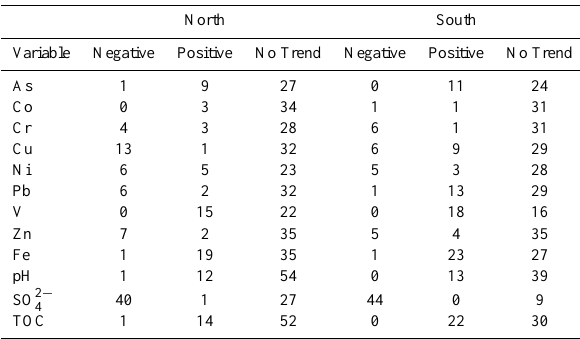
Table 3. Number of sites with statistically significant ( p < 0 . 05) negative or positive Theil slope trends or no significant trend de- tected.